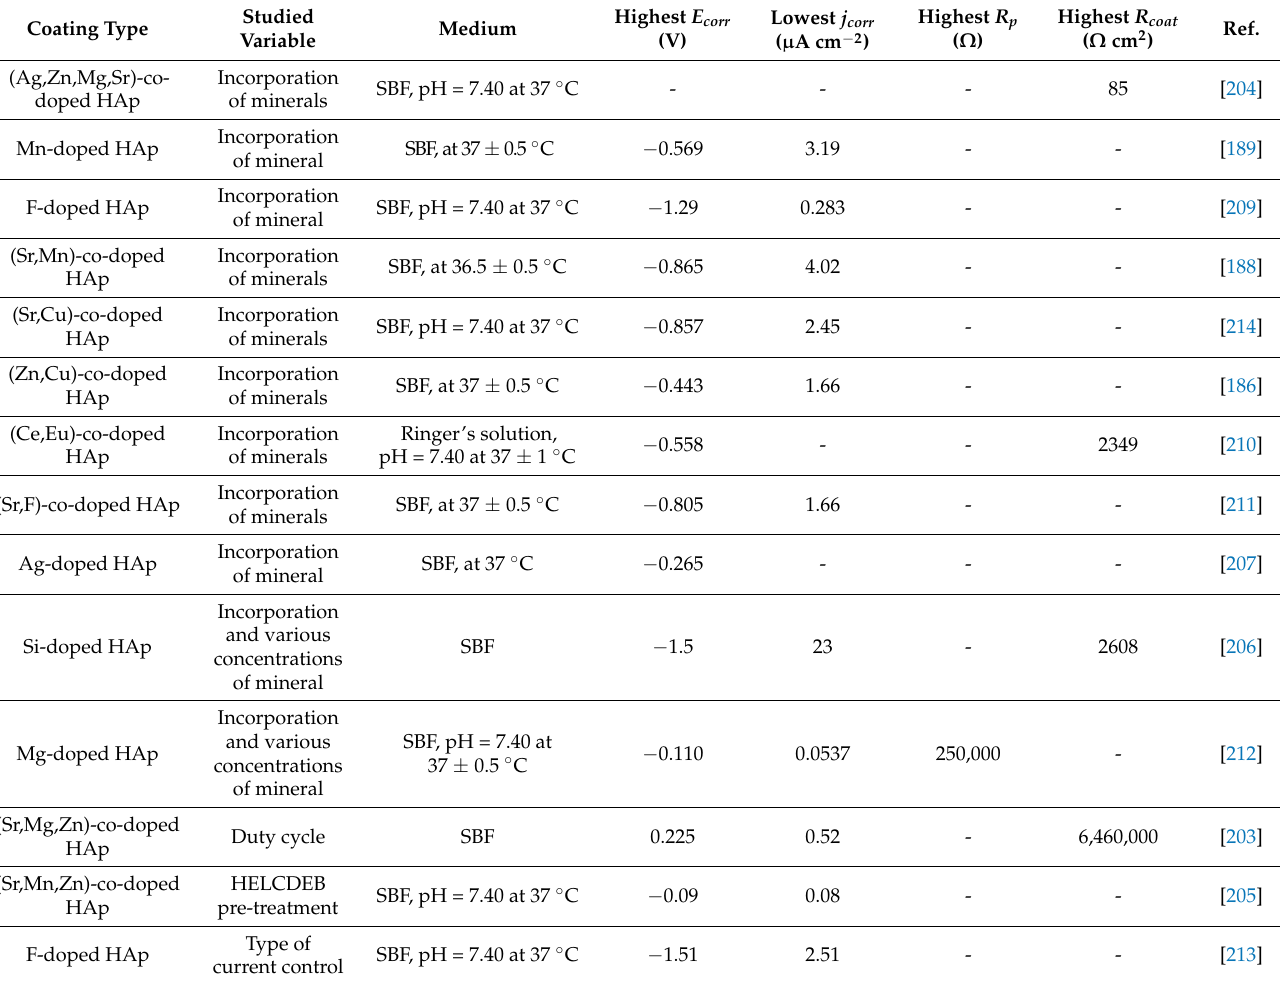
Table 10. The corrosion parameters of electrodeposited mineral(s)-doped HAp coatings. E corr , j corr , and R p are corrosion potential, corrosion current density, and polarization resistance, respectively. These parameters are obtained from potentio- static polarization assay. R coat is the coating area resistance obtained by fitting the EIS data via an appropriate equivalent electrical circuit (EEC). The polarization resistance, R p is stated in some